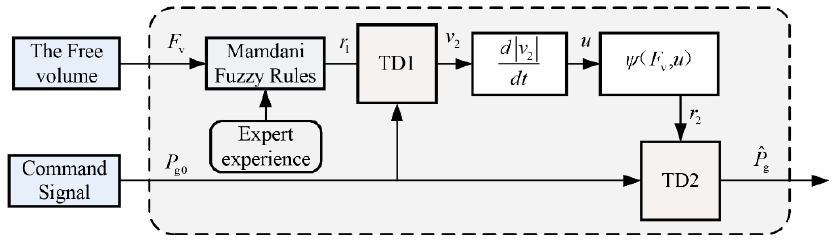
Figure 10. Schematic diagram of the SOA-TD.